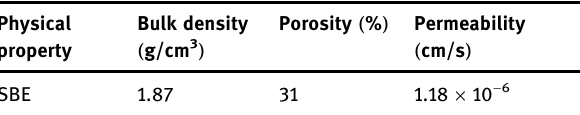
Table 2: The physical properties of the soil before the beginning of the experiment